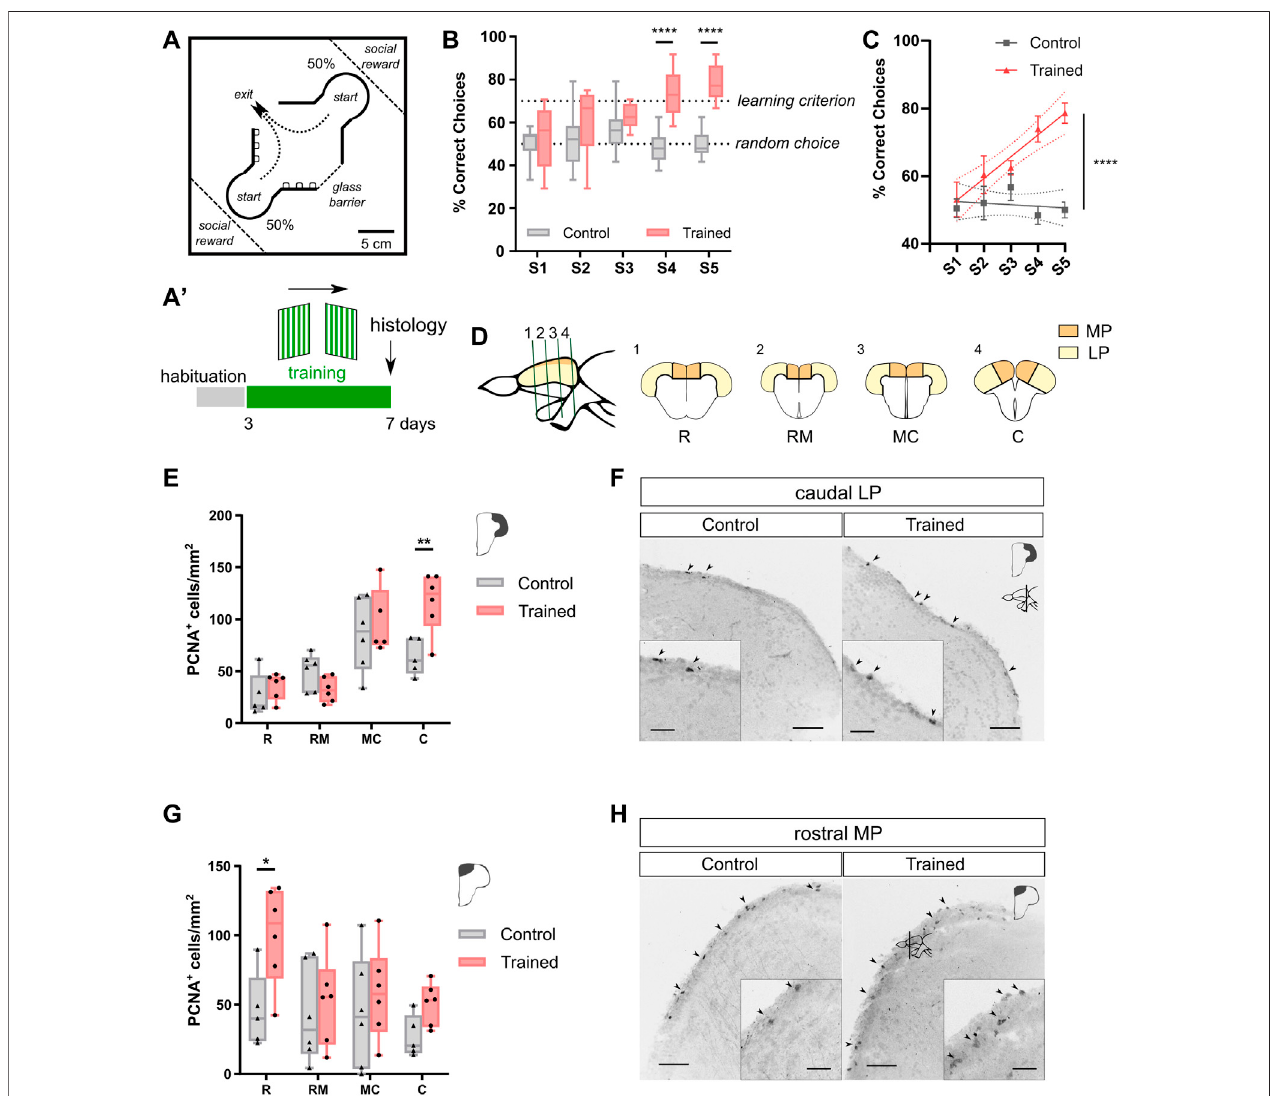
FIGURE 1 | Training adult zebra fi sh in a rhomboid maze boosts cell proliferation in the rMP and the cLP. (A) . Experimental device. The maze contains two starting boxes,andtwopossibleexits,oneofwhichisblockedwithaglassbarrier.Fishweretrainedto fi ndthecorrectexit,orientatingthemselveswithcuesplacedontwowalls. On the edges of the tank, two glass enclosures contained fi sh ’ s conspeci fi cs as social reward. On each trial, fi sh were placed in a start box, and, once they reached the central arena, a correct choice was scored if they swam through the exit, and a failure if they bumped against the glass barrier. Each daily session consisted of 24 trials. (A ’ ) Behavioral schedule. Cue patterns and exit position (arrow) are speci fi ed above. Fish were habituated to the experimental tank for 2 days, and subsequently trainedfor fi veconsecutivedays. (B) .LearningcurvesforTrainedandControlindividuals.Trained fi shreachthelearningcriterionafter fi veconsecutivesessions.Controls do not exhibit a learning curve (Two-way RM ANOVA, Treatment effect: F (1, 14) = 25.78 with p = 0.0002, Session effect: F (4, 56) = 3.422 with p = 0.0143. Bonferroni ’ s multiple comparisons test, **** depicts p < 0.0001. Trained, N = 8; Control N = 8). Dashed line at 70% correct choices depicts learning criterion; dashed line at 50% correctchoicesindicatesrandomchoice. (C) .SimplelinearregressionforTrainedandControlindividuals(ANCOVA,F (1,77) =9.010.****depicts p < 0.0001.Trained,N= 8;ControlN=8). Dashedlineindicates95%con fi denceintervals. (D) .Left:Sagittalschematic viewofzebra fi shforebrain,indicating thepositionofthecrosssections on the right. Right: Cross sections of zebra fi sh telencephalon along rostro-caudal axis (R: rostral, RM: rostro-medial, MC: medio-caudal, C: caudal). The colored regions depict MP and LP. (E) . PCNA + cells in LP. (Two-way ANOVA, Treatment effect: F (1, 37) = 3.873 with p = 0.0566, Pallium region effect: F (3, 37) = 20.27 with p < 0.0001. Bonferroni ’ smultiplecomparisonstest,**denotes p < 0.001.Trained,N=6;Control,N=6). (F) .CrosssectionsoftelencephalicpalliumimmunostainedforPCNAincLP of Trained and Control individuals. Scale bar, 50 μ m. Scale bar in higher magni fi cations, 20 μ m. Black arrows indicate representative PCNA + cells. (G) . PCNA + cells in MP. (Two-wayANOVA, Treatmenteffect:F (1,38) =7.796with p =0.0082,Pallium regioneffect:F (3,38) =2.332with p =0.0895.Bonferroni ’ smultiplecomparisonstest, * denotes p < 0.05. Trained, N = 6; Control, N = 6). (H) . Cross sections of telencephalic pallium immunostained for PCNA in rMP of Trained and Control individuals. Scale bar, 50 μ m. Scale bar in higher magni fi cations, 20 μ m. Black arrows indicate representative PCNA + cells.